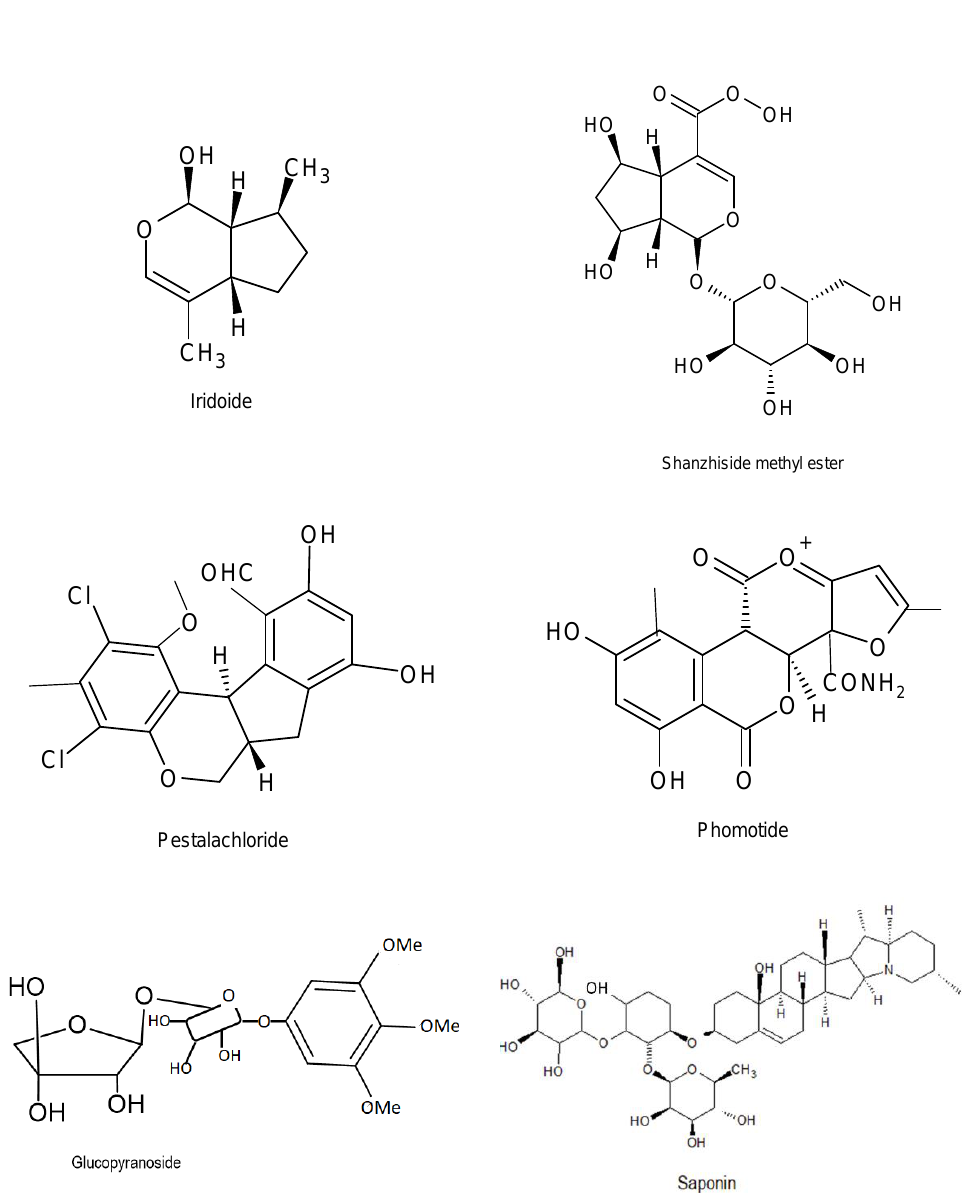
Figure 3. Chemical structures of the bioactive compounds with antifungal activities [33].